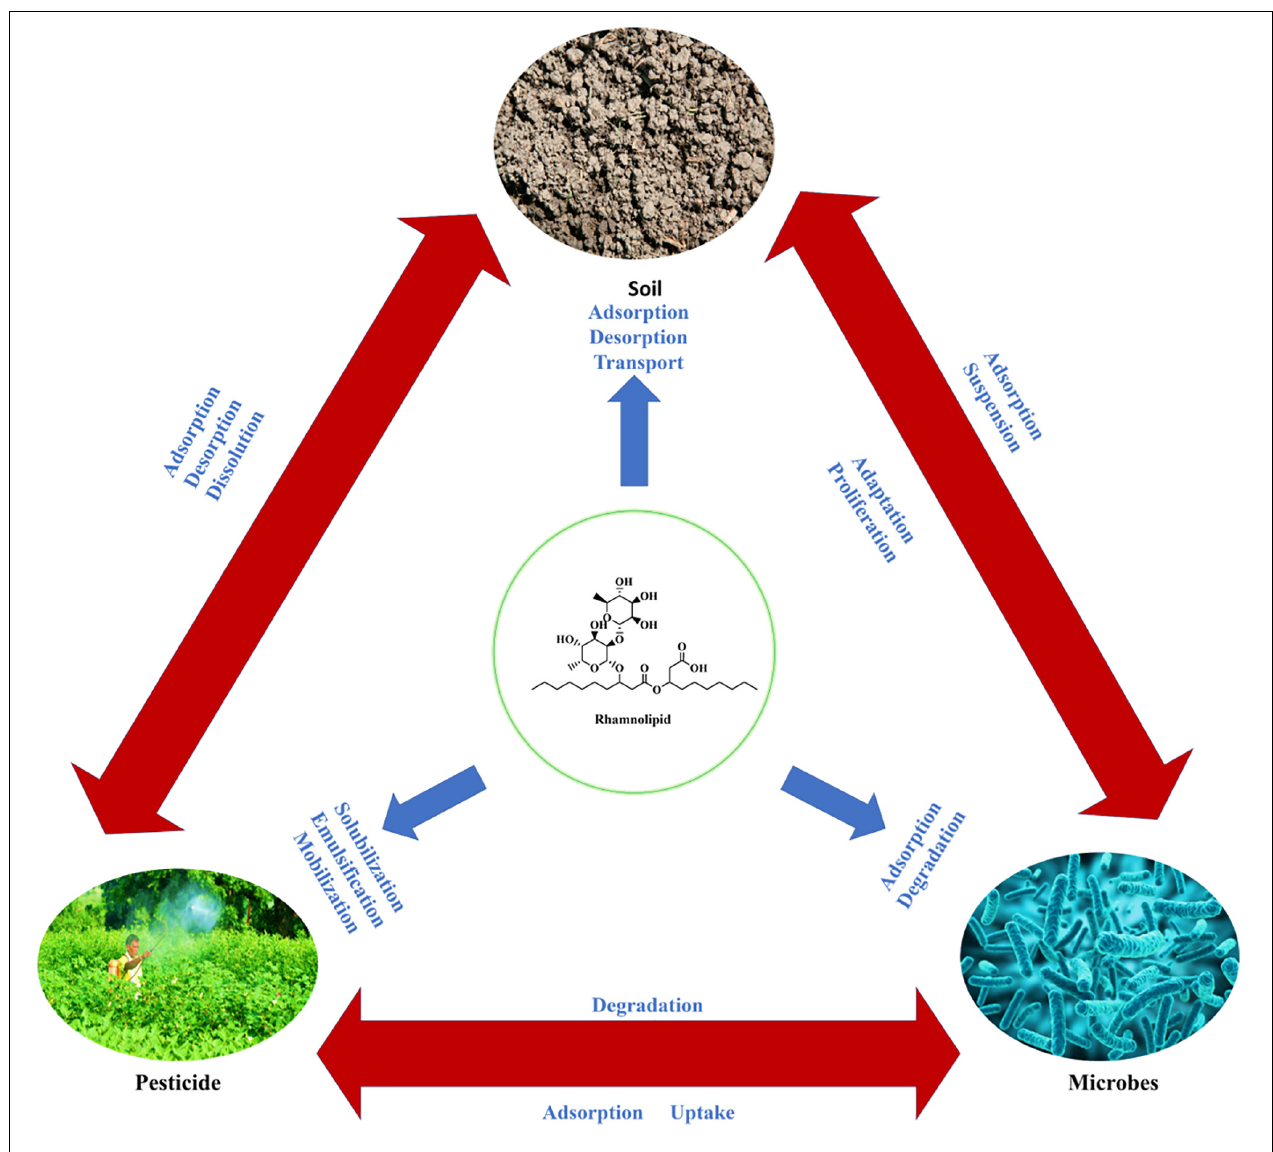
FIGURE 5 | Interaction of biosurfactant with pesticides and the